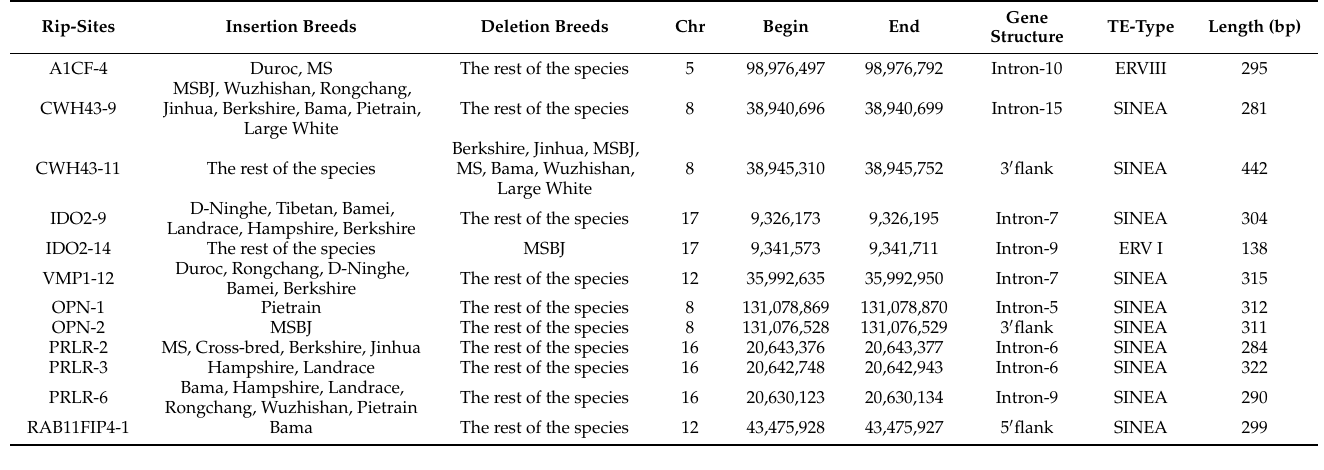
Table 2. The predicted RIP-site information detected in the different small group pig breeds.